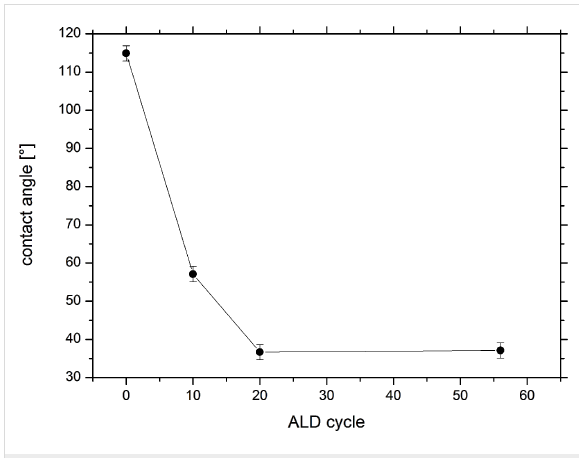
Figure 6: Contact angle measurements as a function of the number of ALD cycles. With increasing thickness of the SiO 2 layer the samples become more